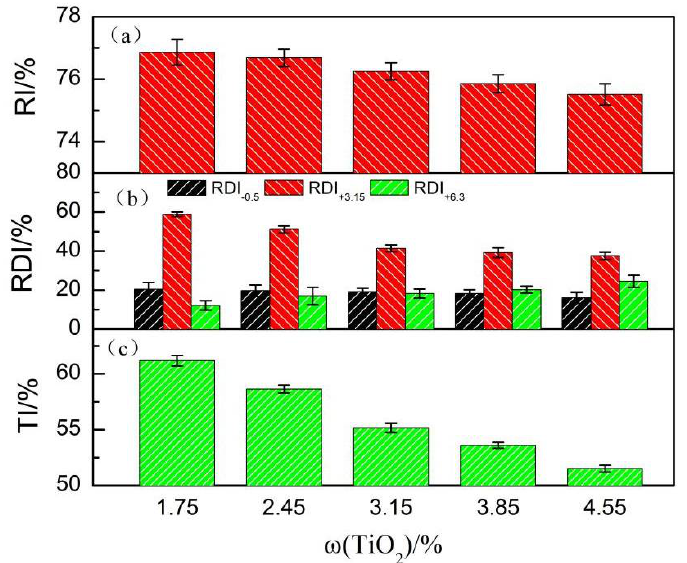
Figure 8. Metallurgical properties of the sinter with various TiO 2 contents:( a ) RI, ( b ) RDI, ( c ) TI.